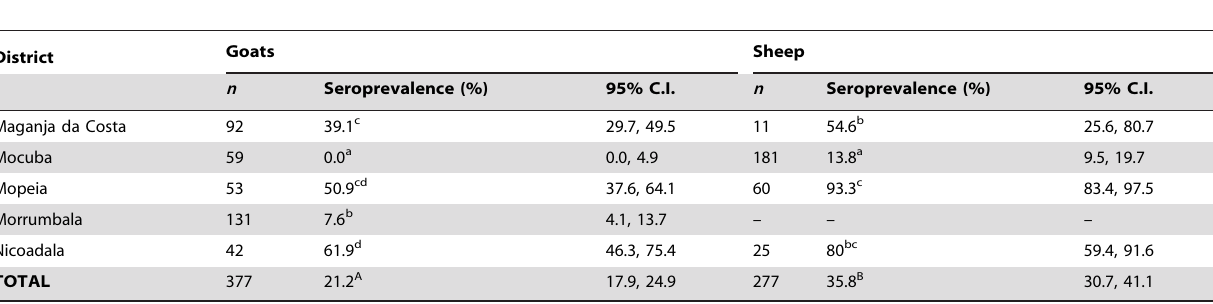
Table 1. RVF seroprevalence in 2007, as determined by virus neutralization test and IgG ELISA.